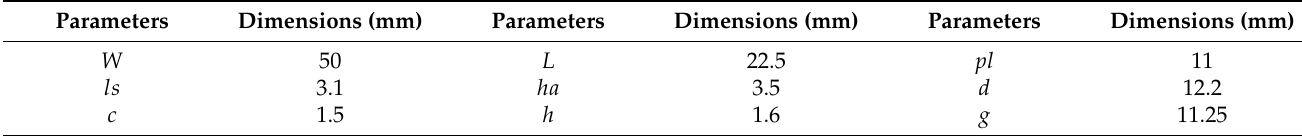
Table 1. Design parameter of the MIMO antenna circular